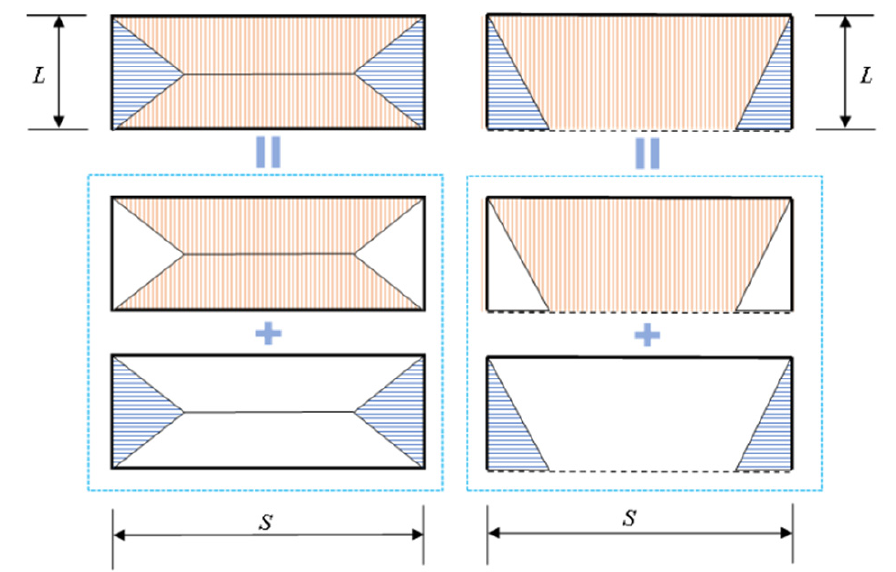
Figure 3. Load division of roof rock layer.